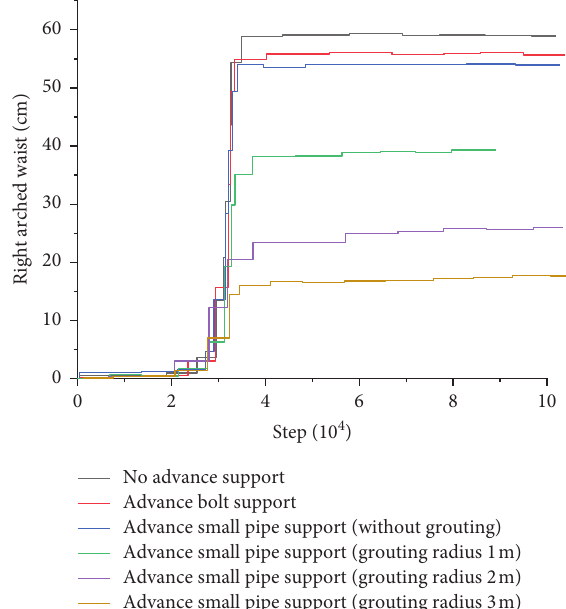
Figure 10: Convergence characteristics of right arch waist under different advanced support